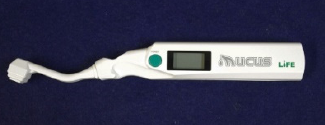
Figure 1. An oral moisture-checking device (Mucus ® ).